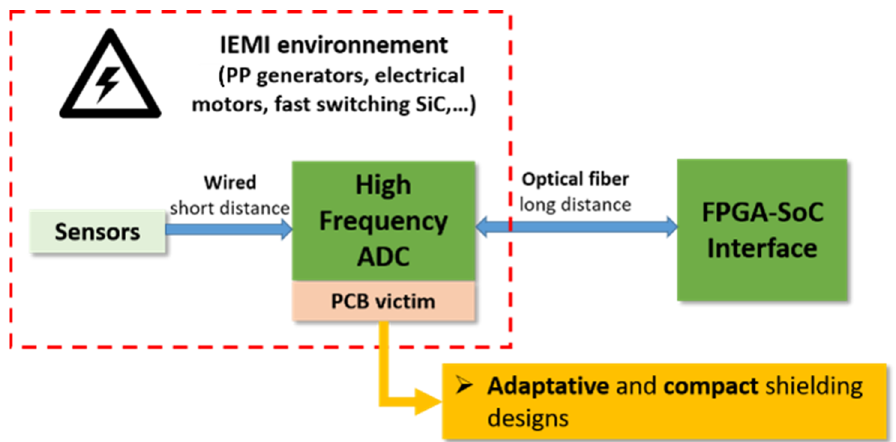
Figure 2. Synoptic diagram of the functional and EM environment of the monitoring system based on FPGA-SoC technology.